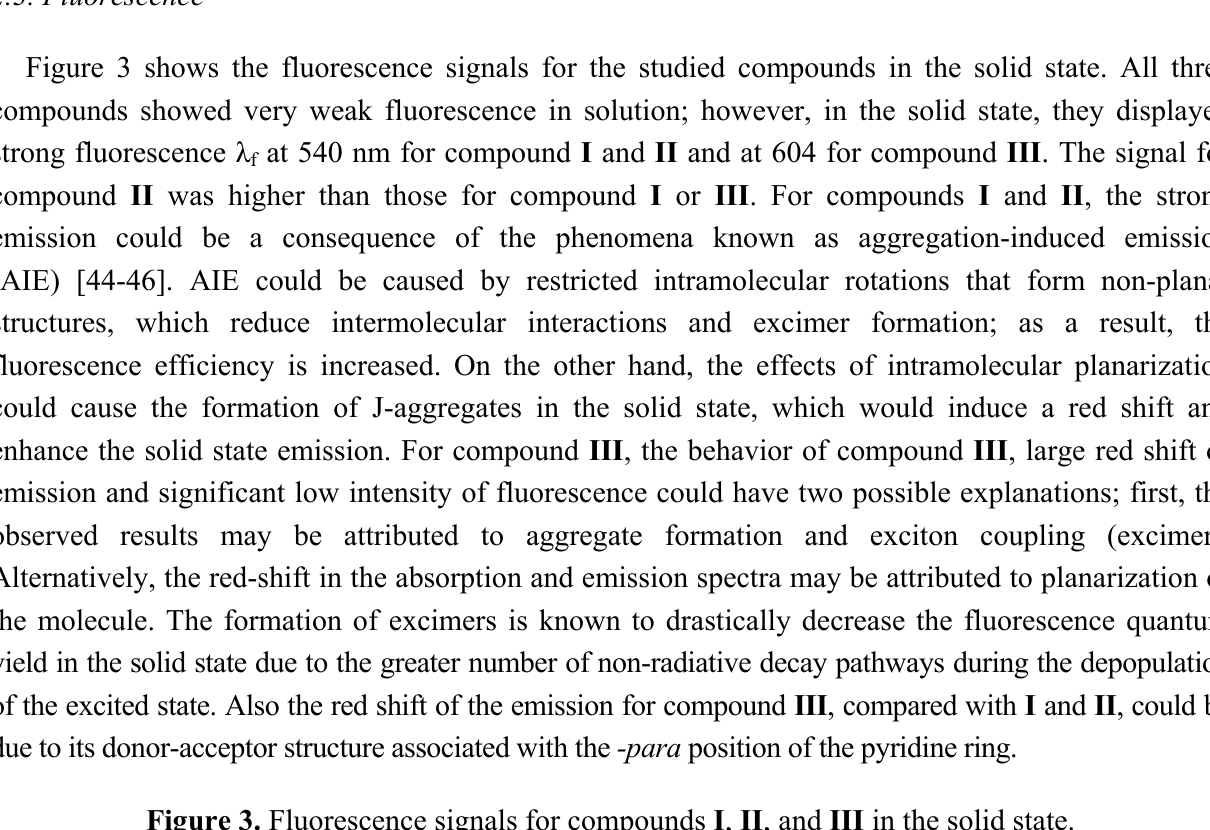
Figure 3. Fluorescence signals for compounds I , II , and III in the solid